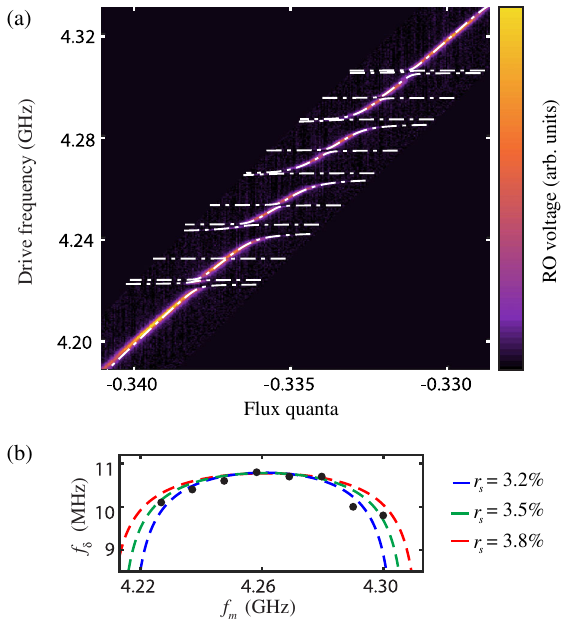
FIG. 5. Qubit flux dependence. (a) The qubit frequency is measured and fit (white line) over a large range of applied flux. Regions near avoided crossings are ignored in the fit (gray). (b) The residual between the measured transitions and the best-fit uncoupled flux dependence matches the expected acoustic Lamb shift (black).